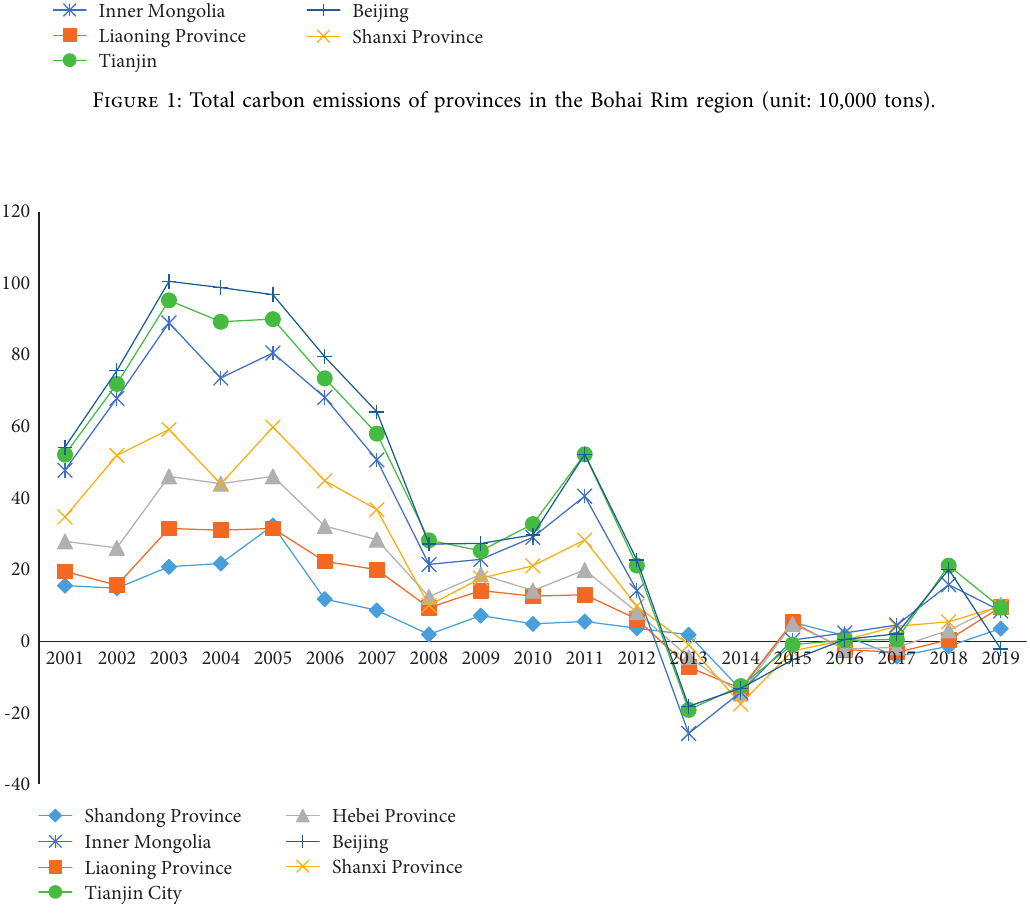
Figure 2: The rate of change of carbon emissions by provinces in the Bohai Rim region (unit: %).